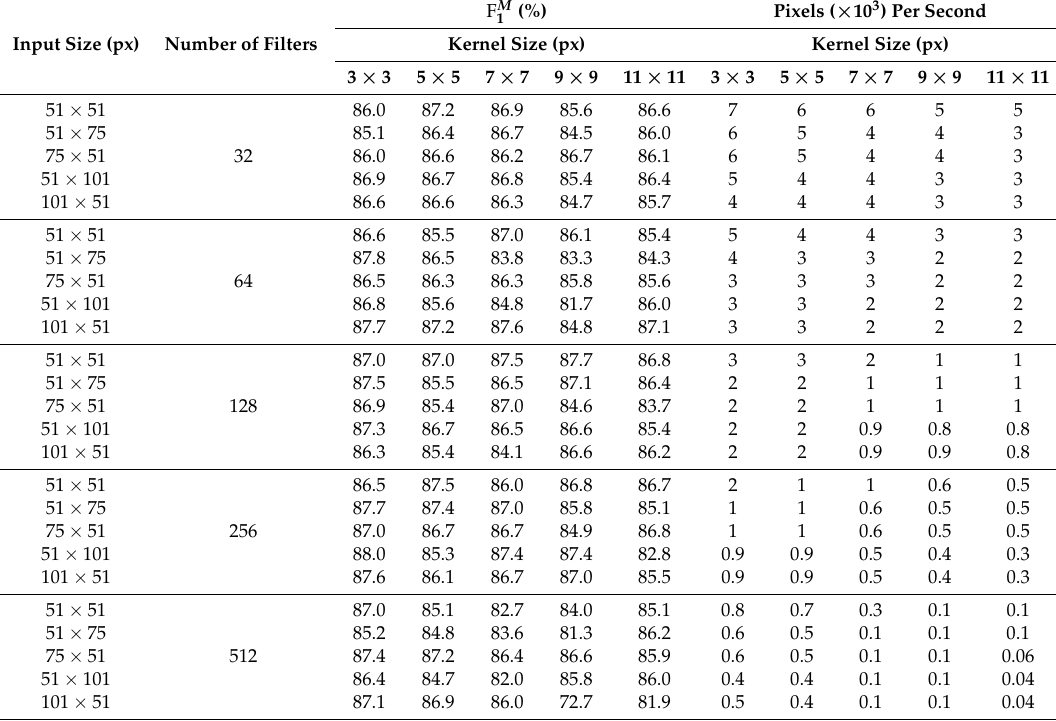
Table 4. Results in terms of F M and pixels per second of the different configurations. All CNN were 1 configured to five layers and one convolution per layer. Results reported represent averages from a five-fold cross-validation scheme over Einsiedeln